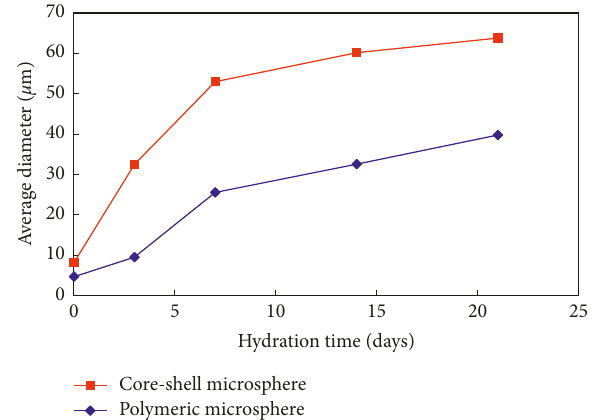
Figure 7: Comparison of average diameter evolution between polymeric and core-shell microspheres.